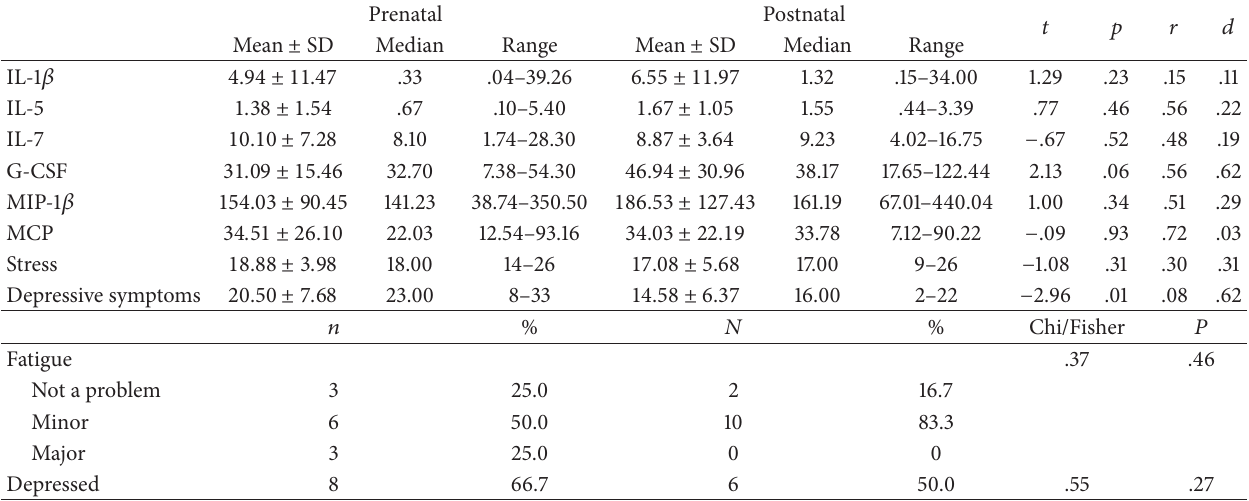
Table 1: Comparison of levels of cytokines and measured variables in late pregnancy and early postpartum.